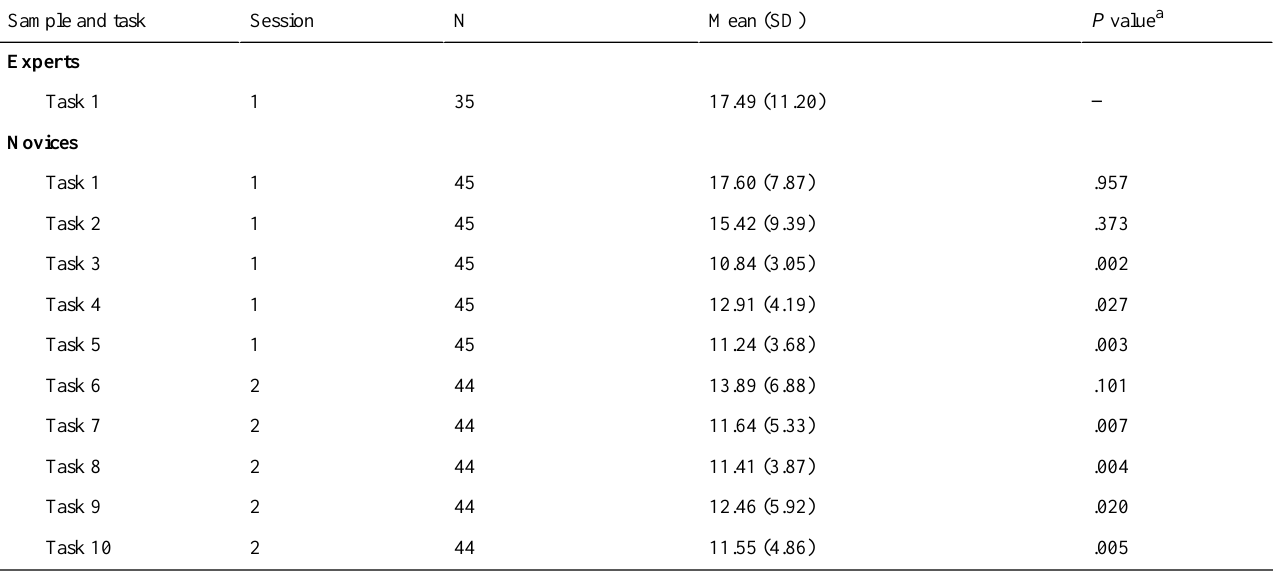
Table 5. Comparison between the operations of experts at the first task of Session 1 and those of novices at each task.